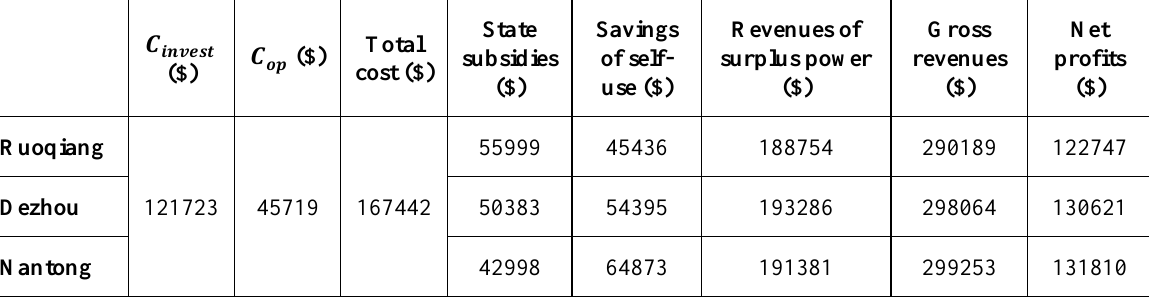
Figure 9 Annual cumulative cost-benefit analysis. Table 5. Life-cycle cost-benefit analysis of the reference buildings in selected